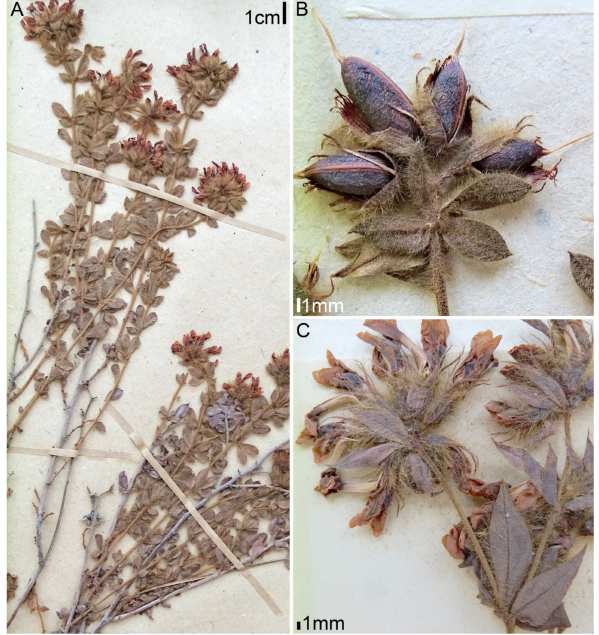
Figure 7. Morphology of Lotus hirsutus : ( A ) habit (herbarium specimen: Turkey, G. Ertem 25071, ISTE); ( B ) fruits (herbarium specimen: Turkey, A. Baytop et al. 10.063, ISTE); ( C ) umbels at anthesis (herbarium specimen: Turkey, A. & T. Baytop 7075, ISTE).